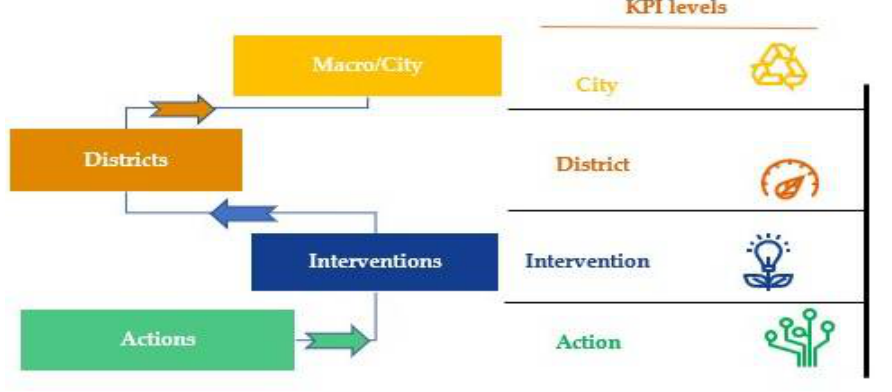
Figure 2. Development of KPIs at different